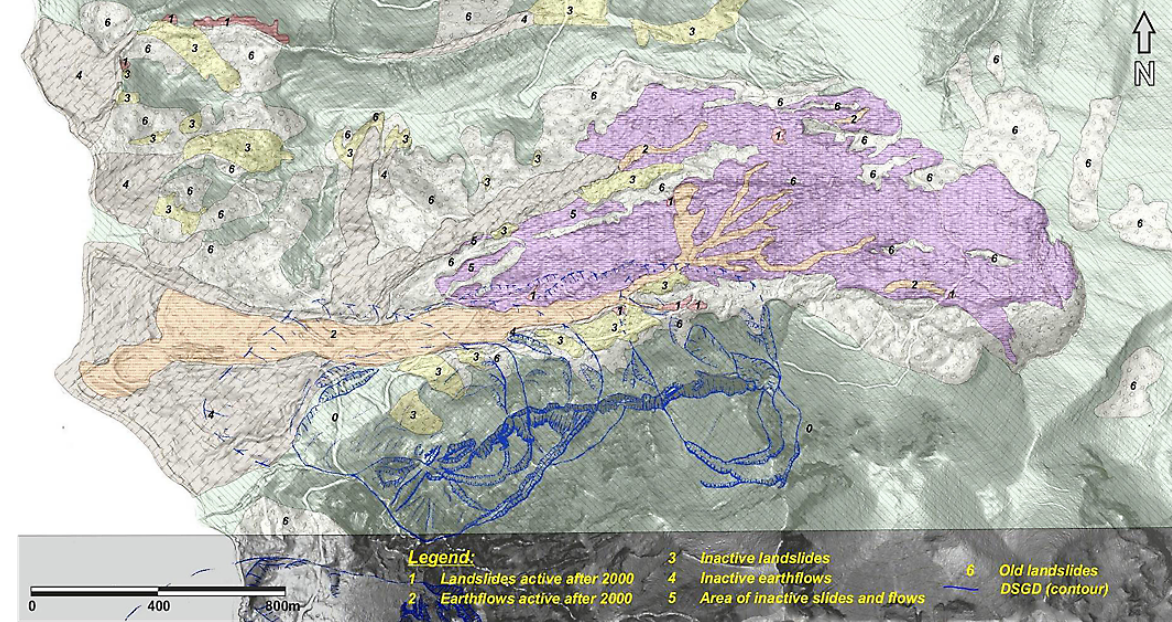
Fig. 4. Landslide inventory map of the area of Gschliefgraben. Slope failures comprise more than 50% of the area.